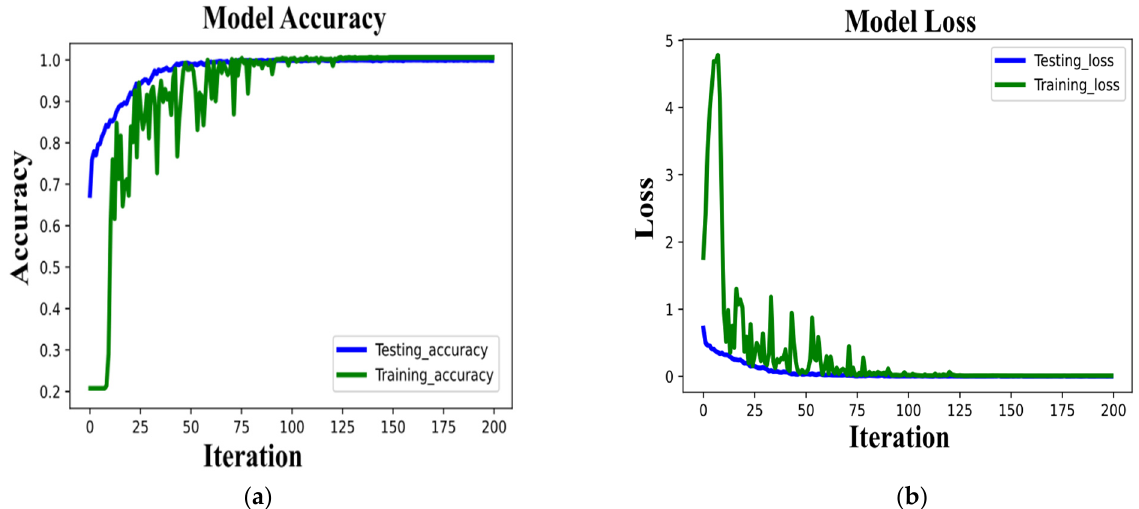
Figure 8. ( a ) The training and testing accuracy of the proposed model. ( b ) The loss history of the proposed model for training and testing set.